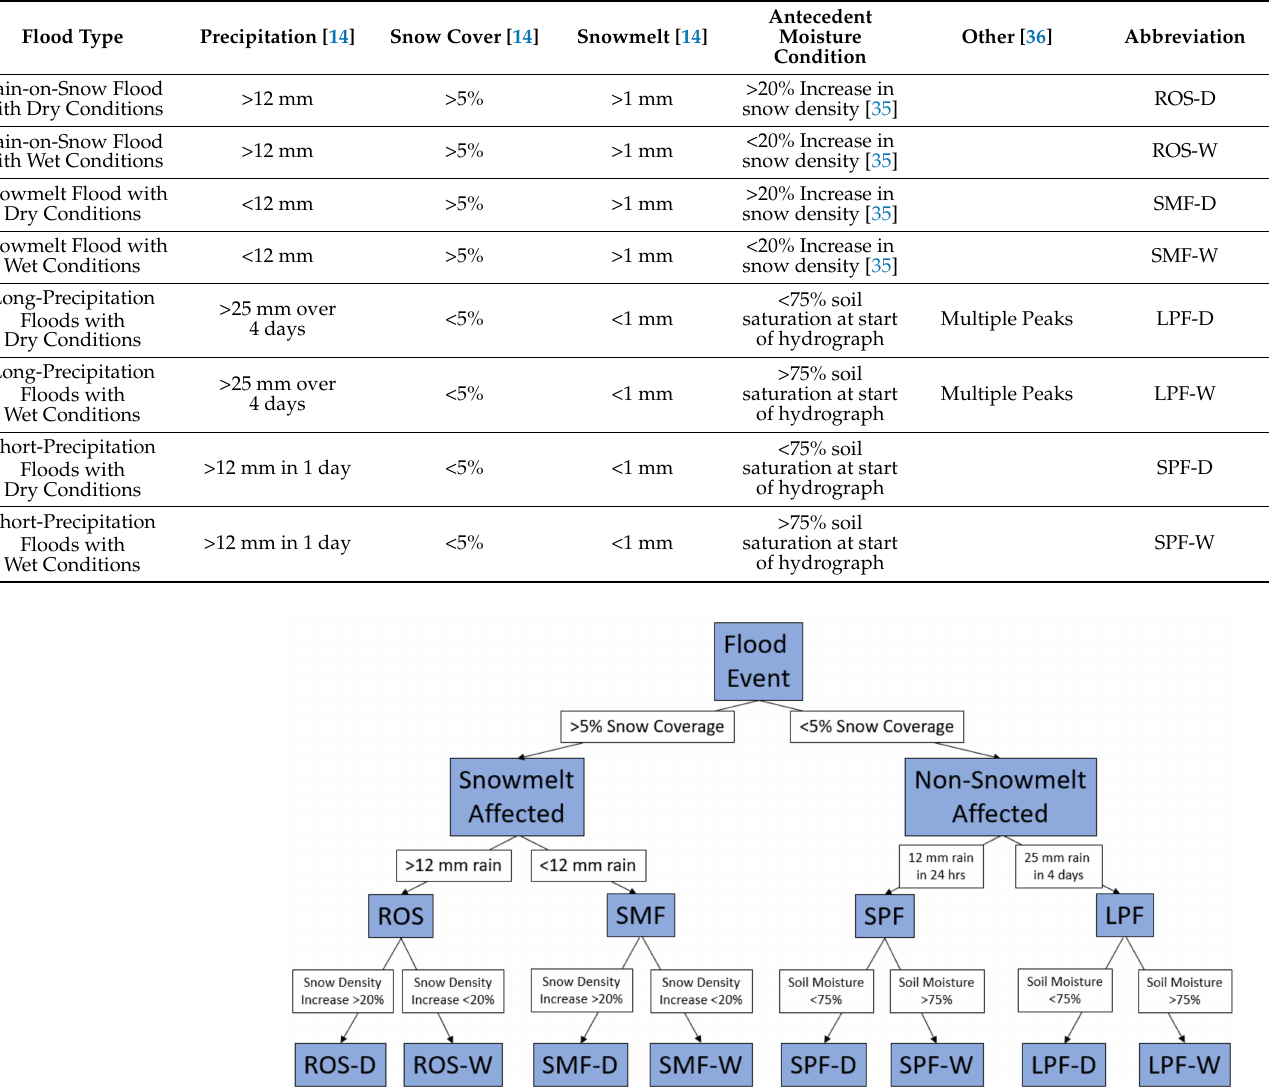
Table 3. Flood typology used in this study. References that were used to define the threshold values are presented in the square brackets.